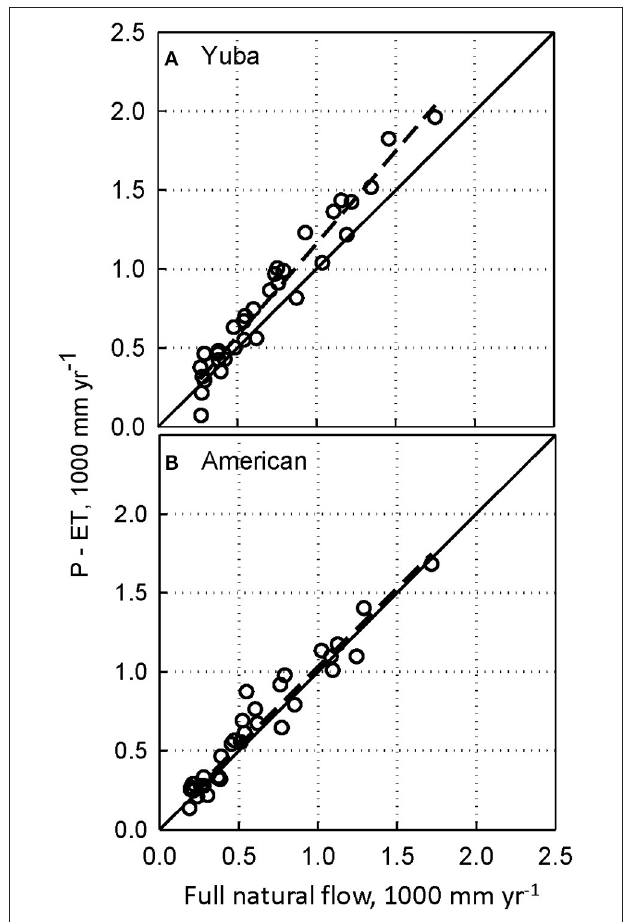
FIGURE 10 | Water balance for the (A) Yuba and (B) American watersheds (1985–2018). Full natural flow is for the respective USGS stream